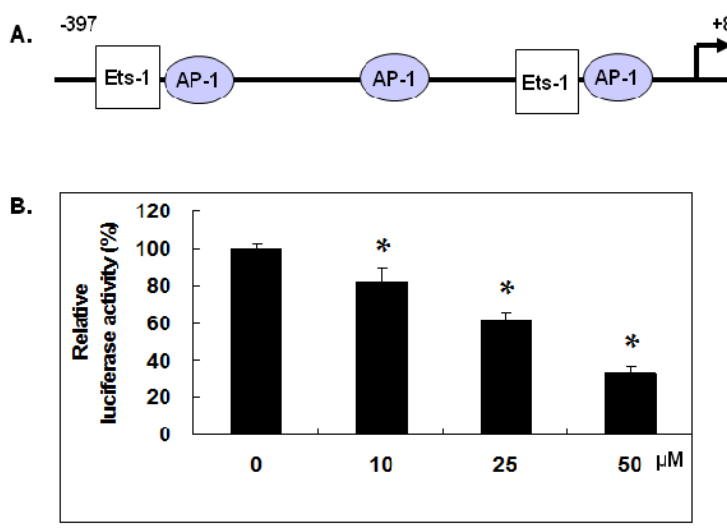
Figure 3. Gallic acid inhibited MMP-1 promoter activity. ( A ) The diagram of MMP-1 promoter containing the AP-1 and Ets-1 binding motifs within the –397 to +87 bp region; ( B ) The MMP-1 promoter activity in NPC-BM1 cells with or without treatment of gallic acid was detected by the dual luciferase assay. The gallic acid dose-dependently decreased the MMP-1 promoter activity in NPC-BM1 cells compared to the control. Data were representative results from experiments repeated at least three times. * p < 0.05 versus vehicle control.